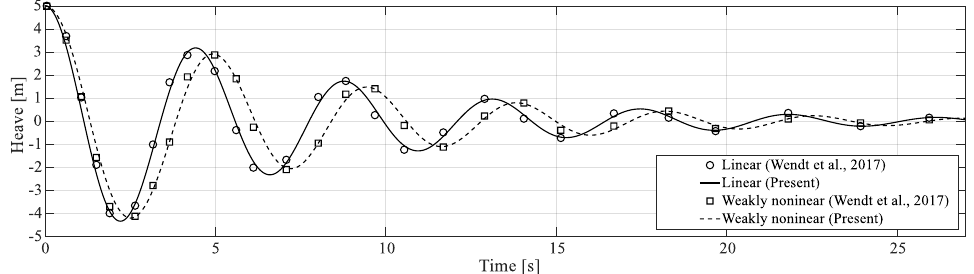
Figure 4. Comparison of the heave free-decay test (5.0 m initial displacement).